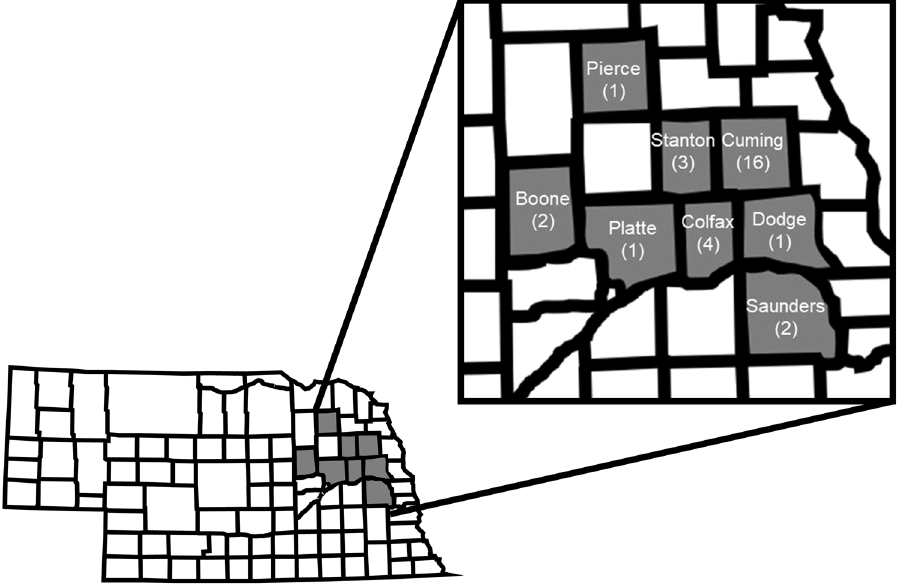
Figure 1. Nebraska state map showing counties from which western corn rootworm populations were collected in gray. The number of western corn rootworm populations collected from each county is indicated in parentheses.